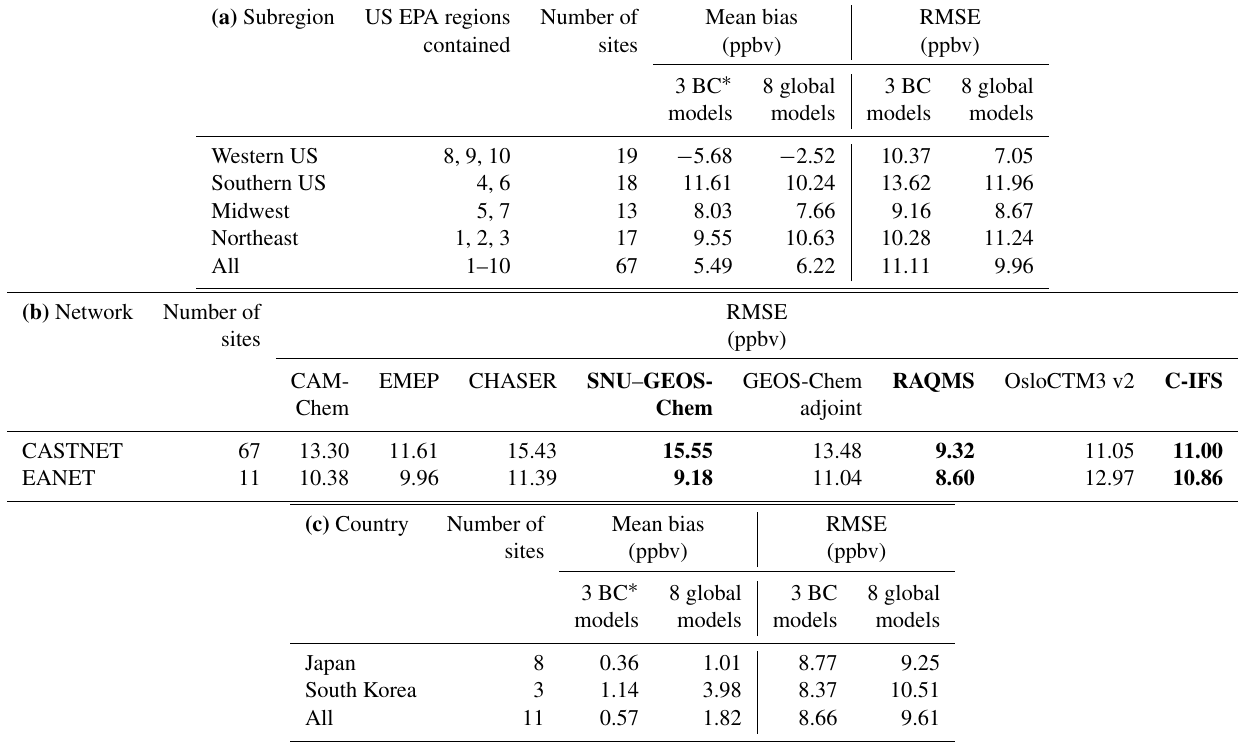
Table 2. (a) Evaluation of the period-mean (1 May–30 June 2010) multi-global model free simulations against the CASTNET observations, only at the sites where 95% of the hourly O 3 observations are available. Evaluation of the individual models is summarized in (b) . (b) Eval- uation of the period-mean (May–June 2010) global model free simulations against the EANET and CASTNET observations. The STEM boundary condition models are highlighted in bold. (c) Evaluation of the period-mean (May–June 2010) multi-global model free simulations against the EANET observations in Japan and South Korea. Evaluation of the individual models is summarized in (b)